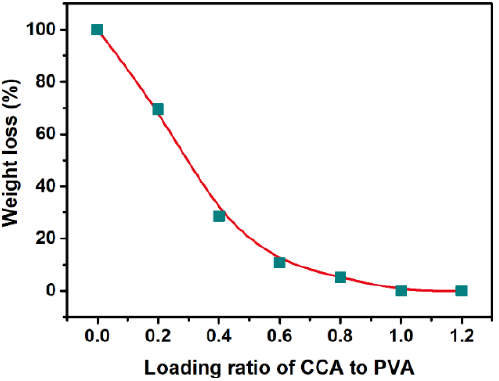
Figure 1. Influences of loading ratio of CCA to PVA on the structural stability of the functional CCA-co-PVA hydrogel coating layer.